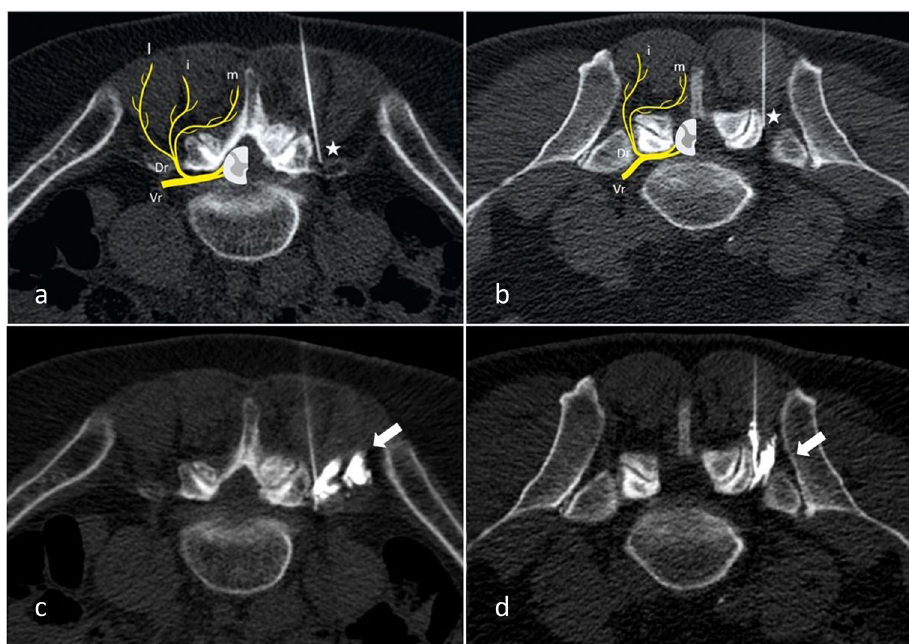
Fig. 8 Medial branch block under CT guidance. a : L4 – 5